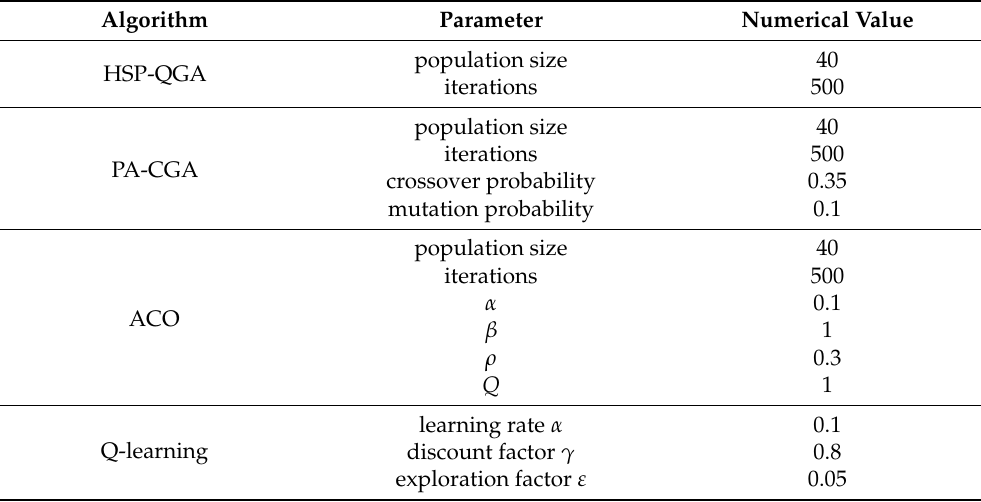
Table 5. Basic parameter setting table of each